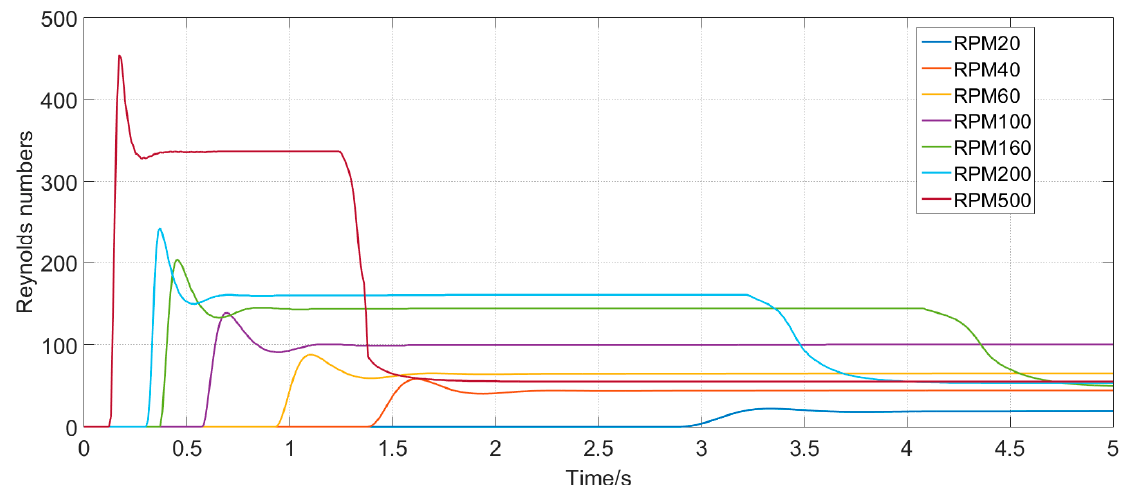
Figure 22. The Reynolds numbers of the hydraulic lock.